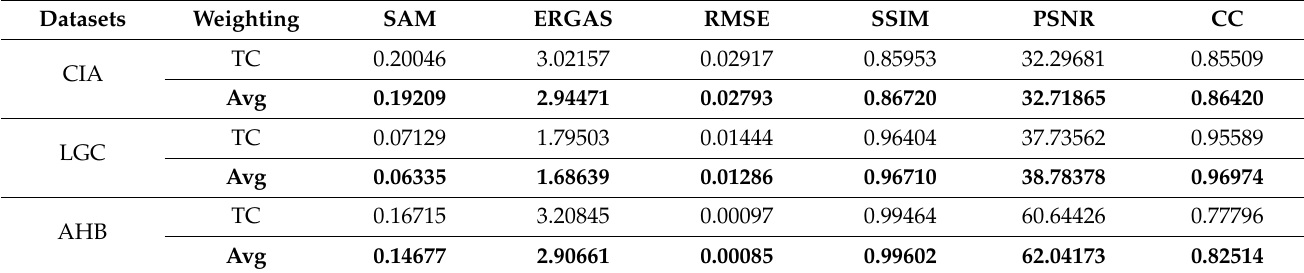
Table 7. Average evaluation values of MSNet using different fusion methods on the three datasets.